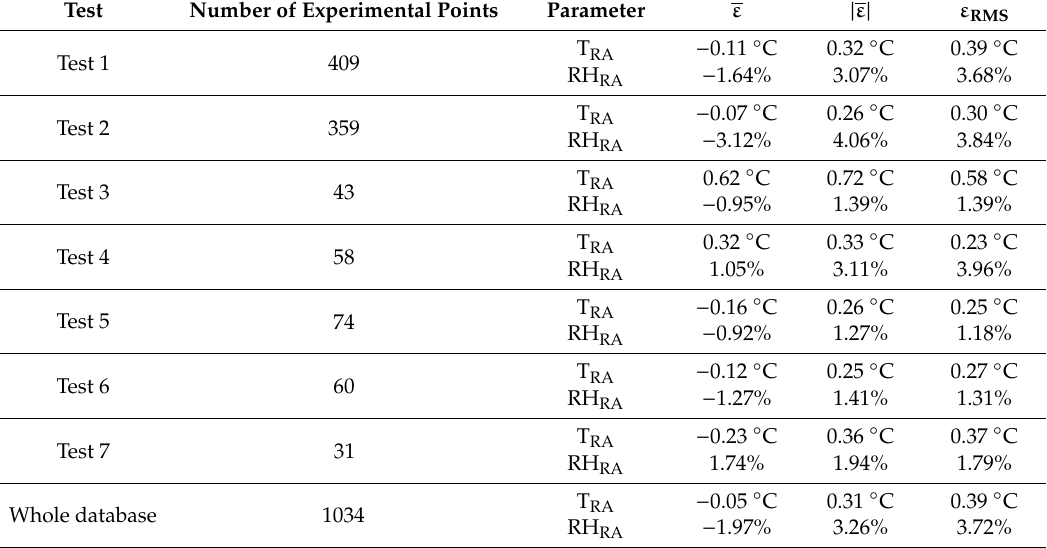
Table 9. Errors between the model predictions and measurements.